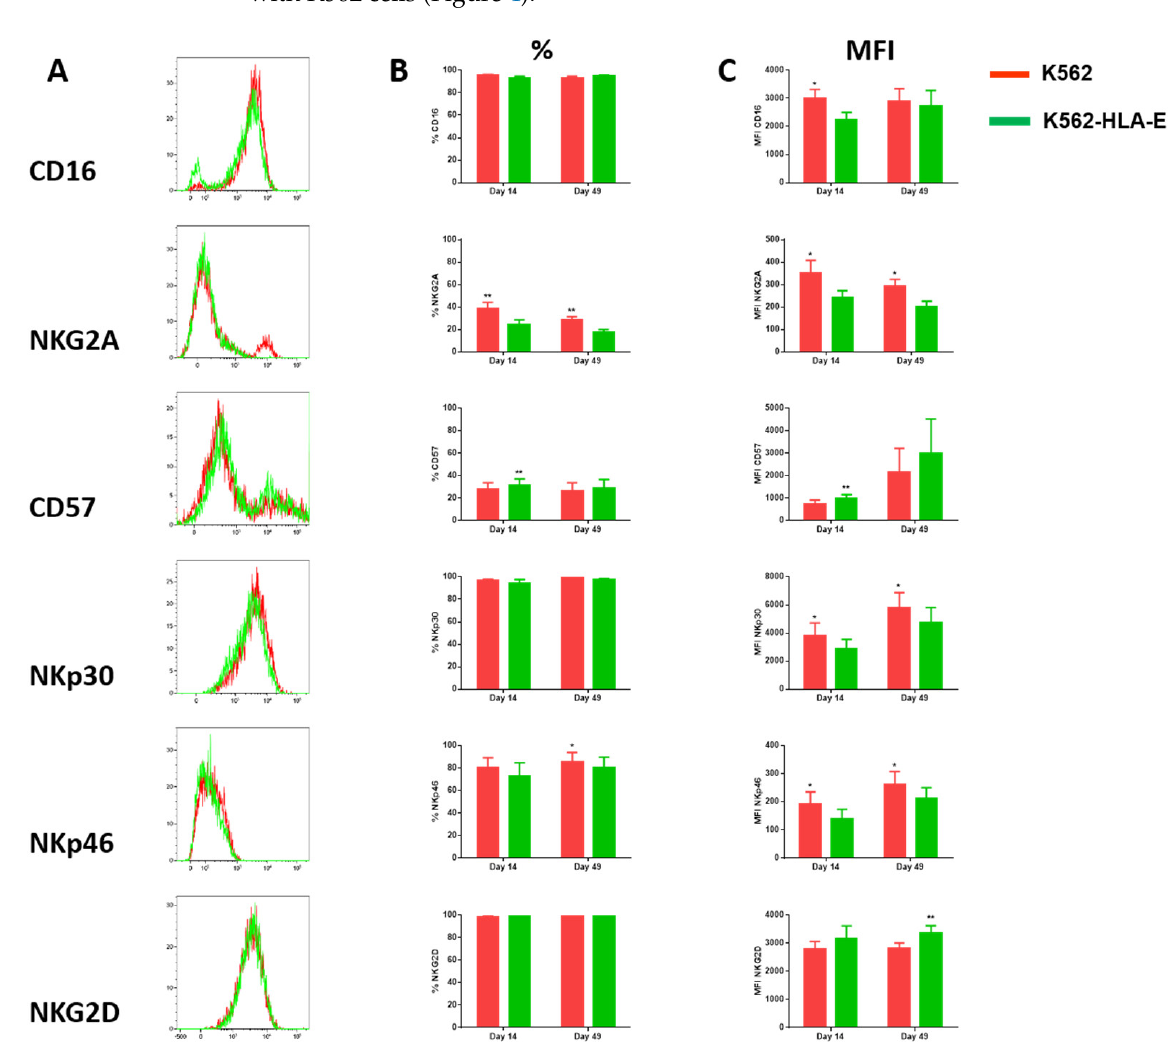
Figure 4. Comparison of receptor expression levels of expanded natural killer (NK) cells using K562 and K562-HLA-E cells. ( A ) Expression of the indicated surface receptors (CD16, NKG2A, CD57, NKp30, NKp46, and NKG2D) on expanded NK cells. Representative histograms are shown in the NK cell subset from the same donor on conventional (K562, red) and adaptive (K562-HLA-E, green) NK cells at day 14 of culture. ( B ) Differences in the expression levels (percentage of positive) of CD16, NKG2A, CD57, NKp30, NKp46, and NKG2D of conventional (K562) and adaptive (K562-HLA-E) NK cells on day 14 and day 49 of culture ( n = 7–9 donors). ( C ) Differences in the expression levels (mean fluorescence intensity MFI)) of CD16, NKG2A, CD57, NKp30, NKp46, and NKG2D of conventional (K562) and adaptive (K562-HLA-E) NK cells on day 14 and day 49 of culture. All data are shown as mean ± SEM ( n = 7–9 independent experiments; * p < 0.05; ** p < 0.01).